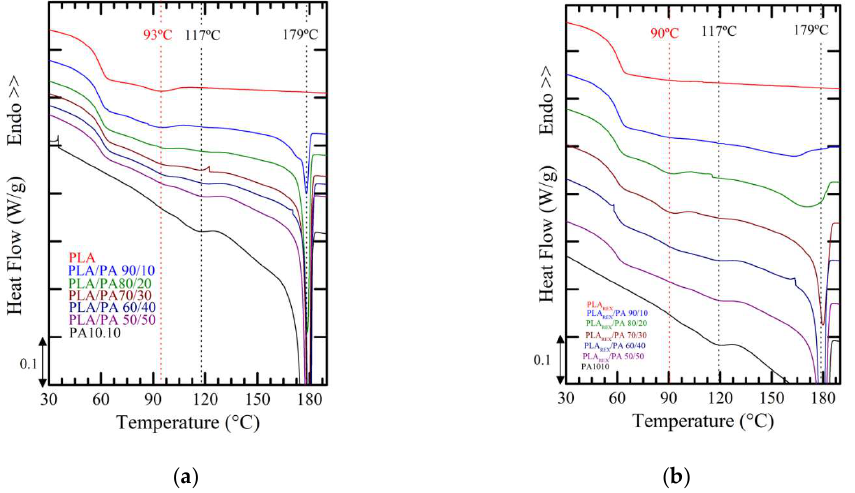
Figure 9. DSC cooling scans at 10 °C/min of ( a ) PLA/PA bioblends and ( b ) PLAREX/PA bioblends.